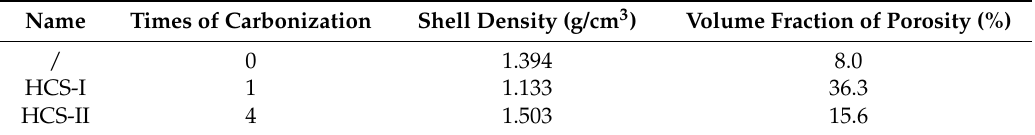
Table 2. Parameters of HCSs before and after carbonization: Shell density and volume fraction of porosity.